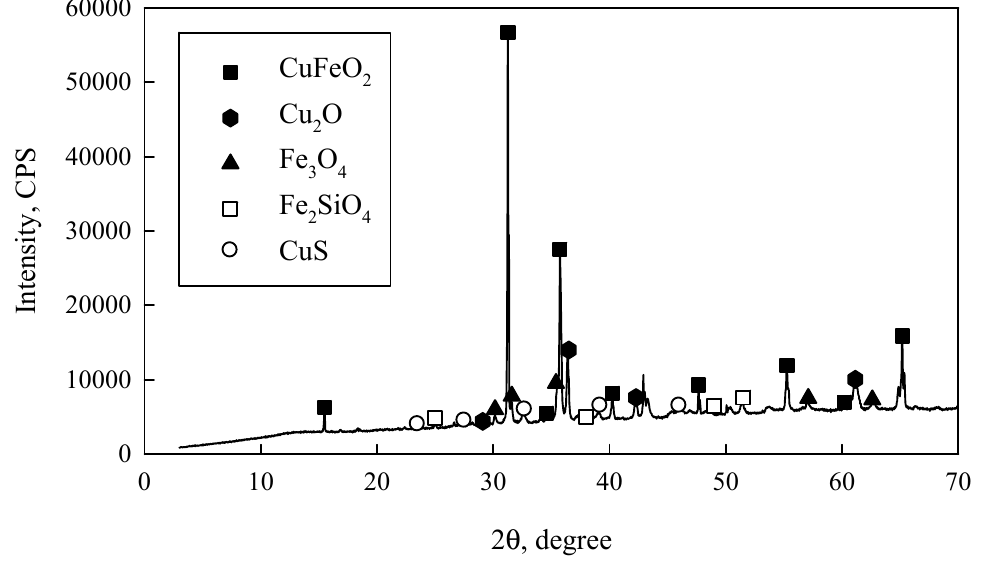
Figure 7. Partially reacted sample of converter slag for a time of 7200 s.